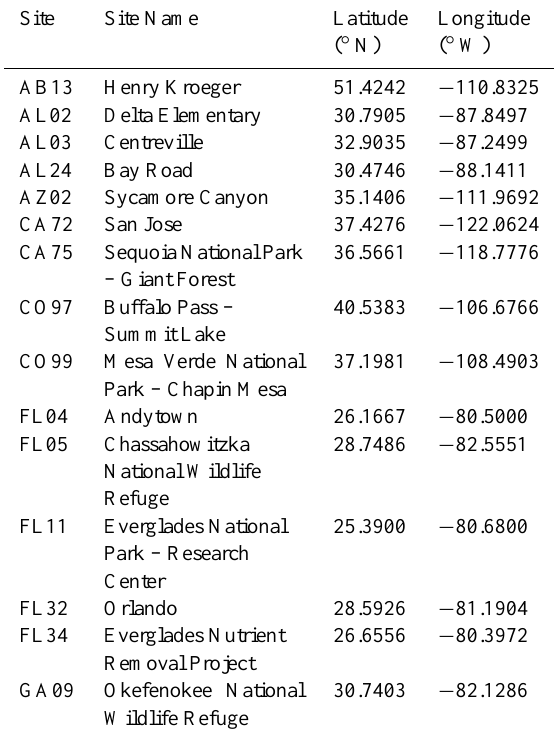
Table A1. Station ID and geographic location of validation stations discussed in Fig. 9. Unlabelled blue dots in Fig. 1 correspond to these stations as